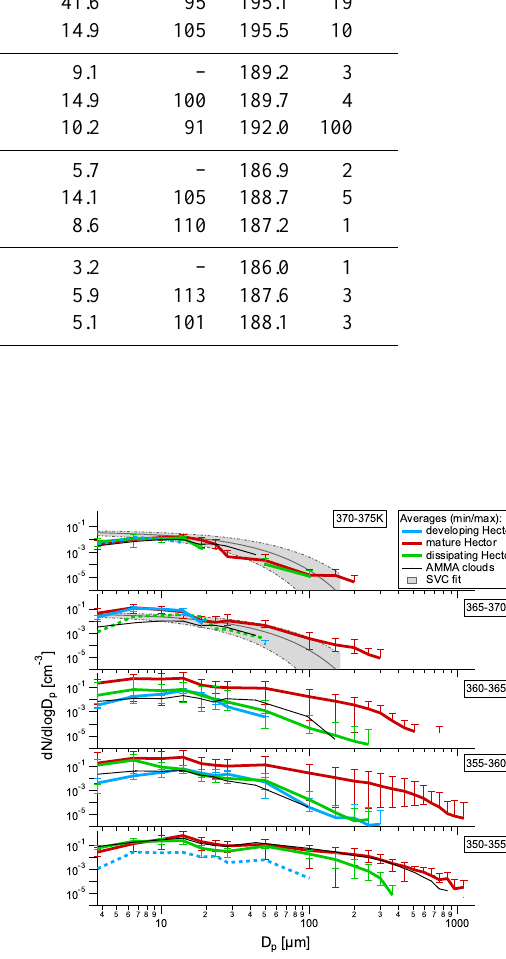
Figure 7. Vertical profile of cloud particles’ size distributions. The averages of the respective Hector development stage (developing, mature, and dissipating) for every potential temperature bin of 5K are given. A dashed line denotes that only one size distribution for the respective Hector class had been measured in the correspond- ing altitude bin. Vertical bars show the position of the minimum and maximum distribution for the respective average. Further pa- rameters can be found in Table 1. Additionally, the mean size distri- butions of measurements inside MCS anvil outflow during African Monsoon Multidisciplinary Analysis (AMMA) and a fit for SVC are